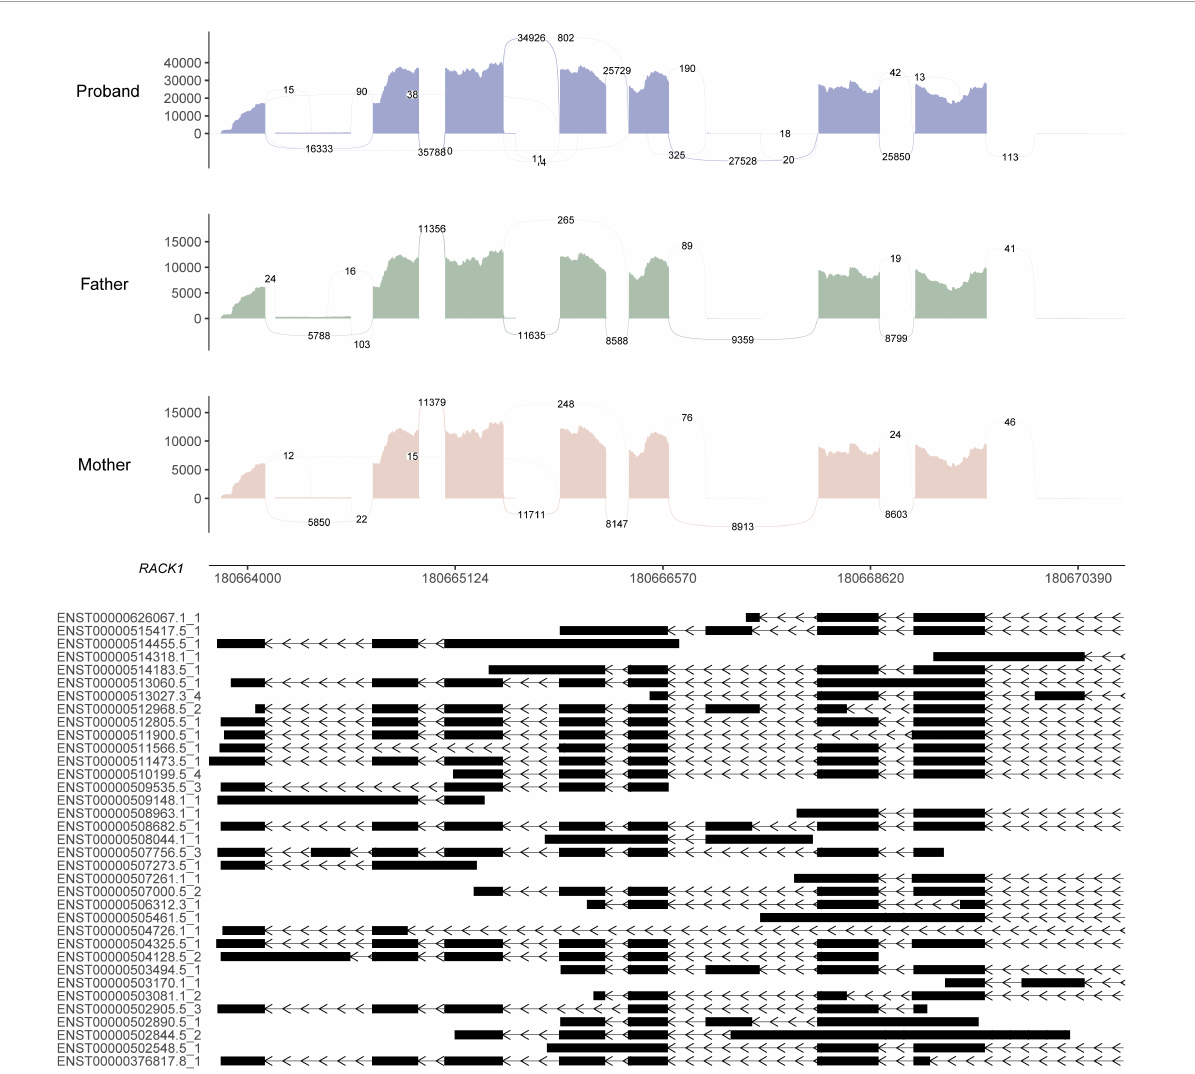
FIGURE3 Sashimi plot of the RACK1 gene. The coverage for each alignment track is plotted as a bar graph. Arcs representing splice junctions connect exons. Arcs display the number of reads split across the junction (junction depth). Genomic coordinates and the gene annotation track are shown below the junction tracks. The aberrant splicing event for the RACK1 gene in the patient is an alternative acceptor site, which is supported by 325 reads. The X-axis is the genomic region for the RACK1 gene. The bottom of the figure shows the different transcripts of the RACK1